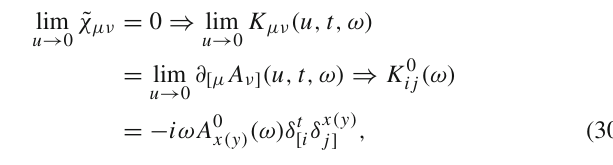
Fig. 5 Real and imaginary parts of the diagonal AC conductivity as functions the θ -angle and the dimensionless frequency variable, w = 3 ω/ 4 π T , for C (cid:12) = (cid:12) L / 2 = 1 (dimensionless combination involv-